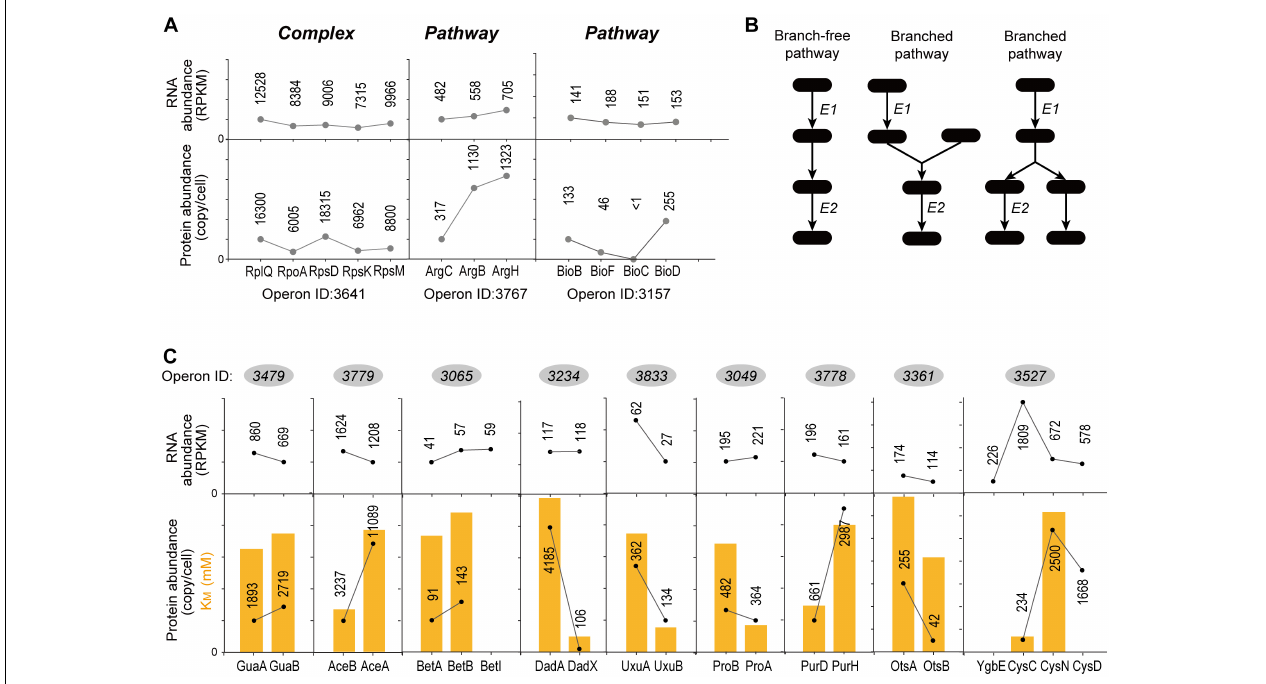
FIGURE 5 | Examples of “Complex” and “Pathway” operons. (A) The gene expression at RNA and protein levels in E. coli K-12 MG1655 strain. The detailed expression level are marked on the data points. < 1 means the expression level is too low to be confidently quantified. (B) Illustrations of the “branch-free” and “branched” pathways. E1 and E2 represent the quantified proteins in the same operon. (C) All nine operons which encodes enzymes that exist in branch-free pathways. Their RNA abundance, protein abundance and K M values were plotted. K M values are plotted in orange bars. Detailed K M values are listed in Table 1 . Detailed pathways are illustrated in Supplementary Figure S6